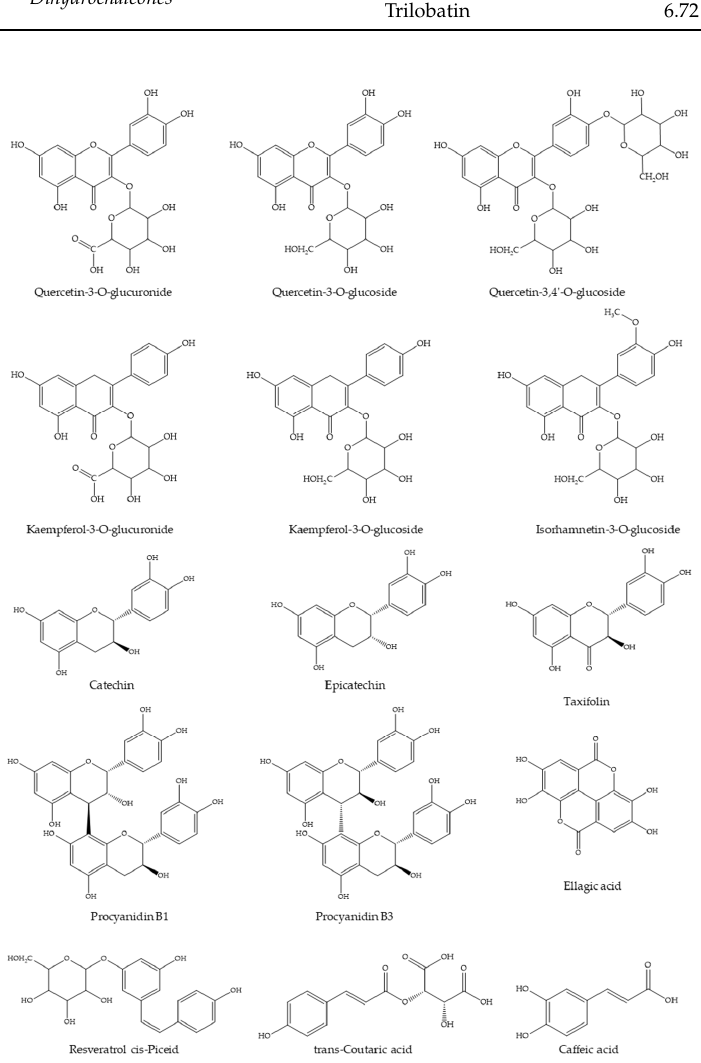
Figure 1. Chemical structures of the most abundant derivatives identified in